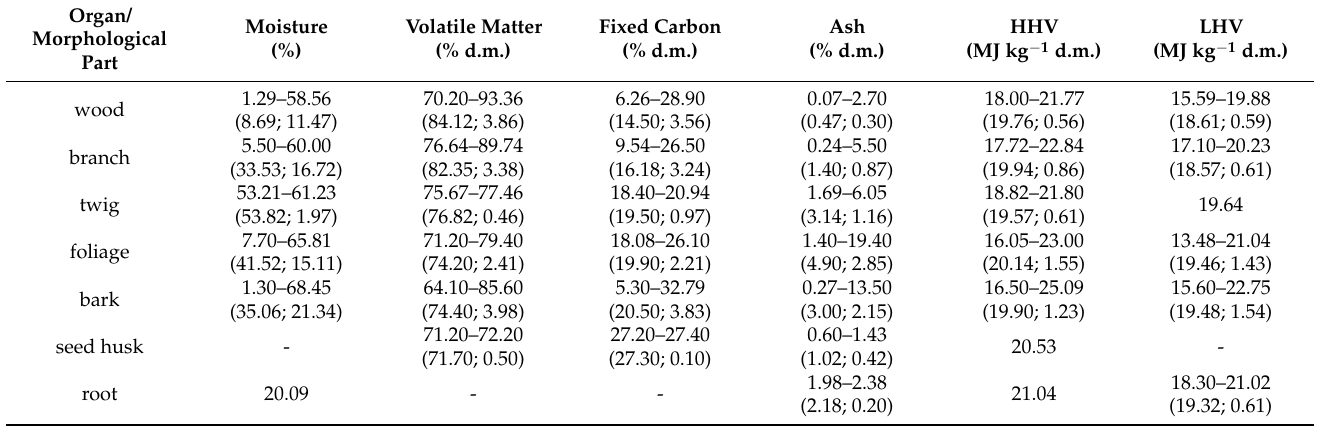
Table A7. Thermophysical properties and proximate analyses of particular trees’ organs without differentiation by type according to the traditional division in